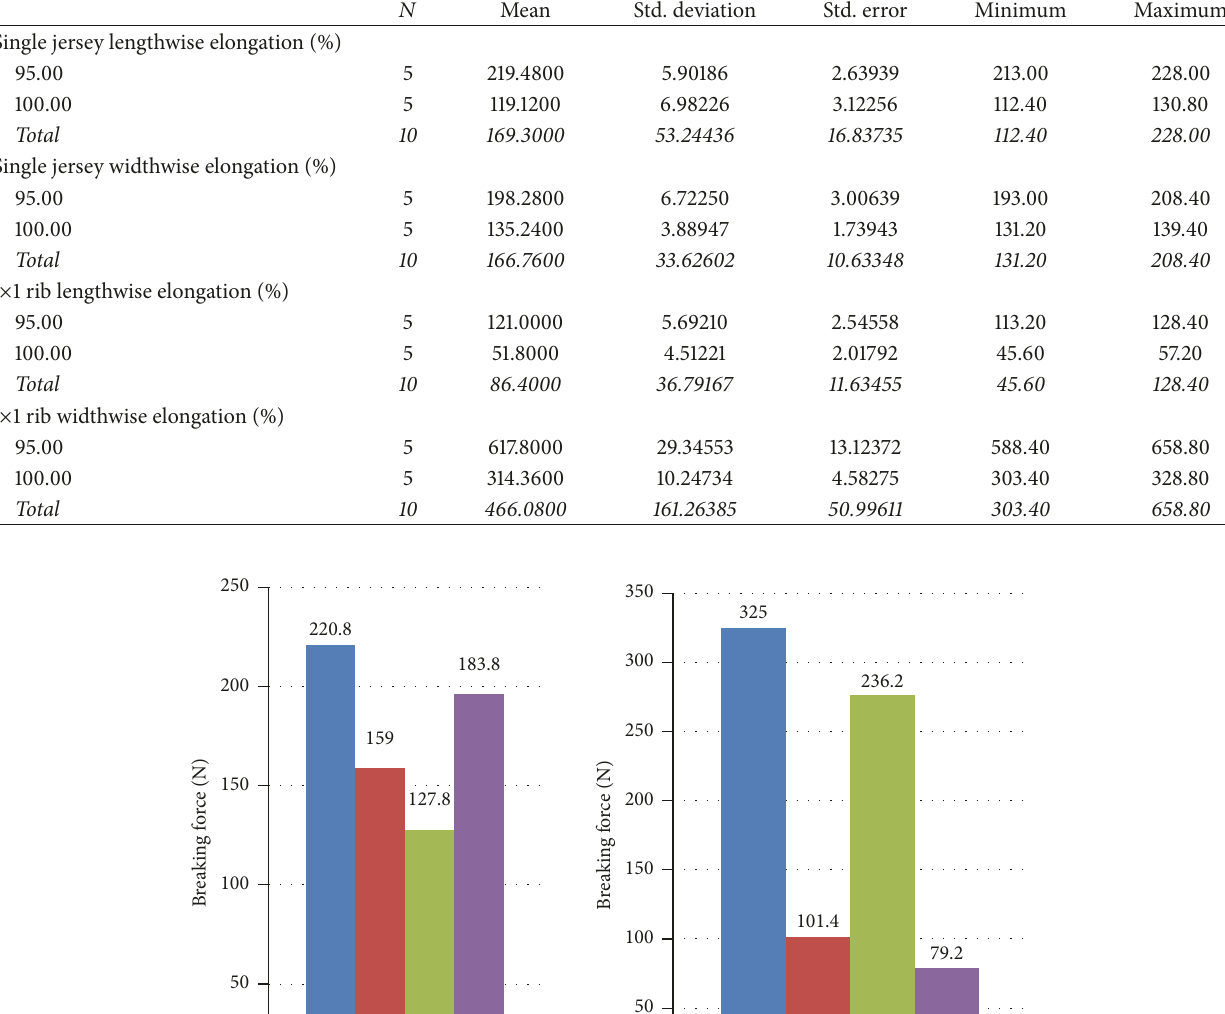
Table 8: Description for elongation (%) of single jersey and 1 × 1 rib knitted fabrics made from 100% cotton and cotton/Lycra (95/5%).